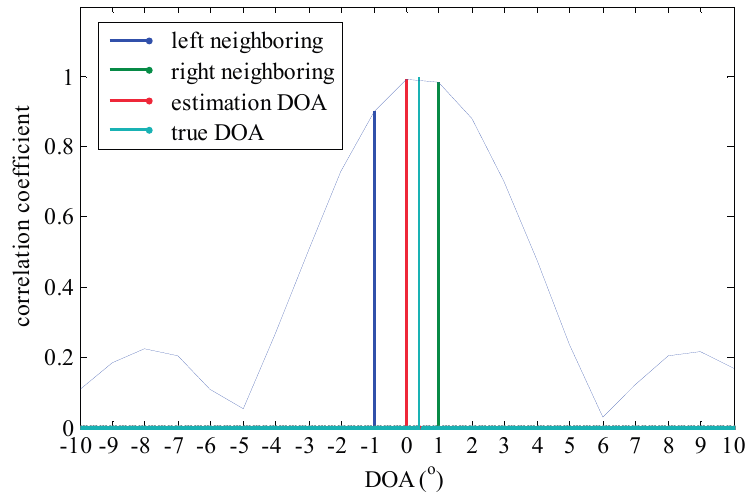
Figure 3. Off-grid and on-grid DOA estimation